Question: Judging by this figure, is the value going up or going down?
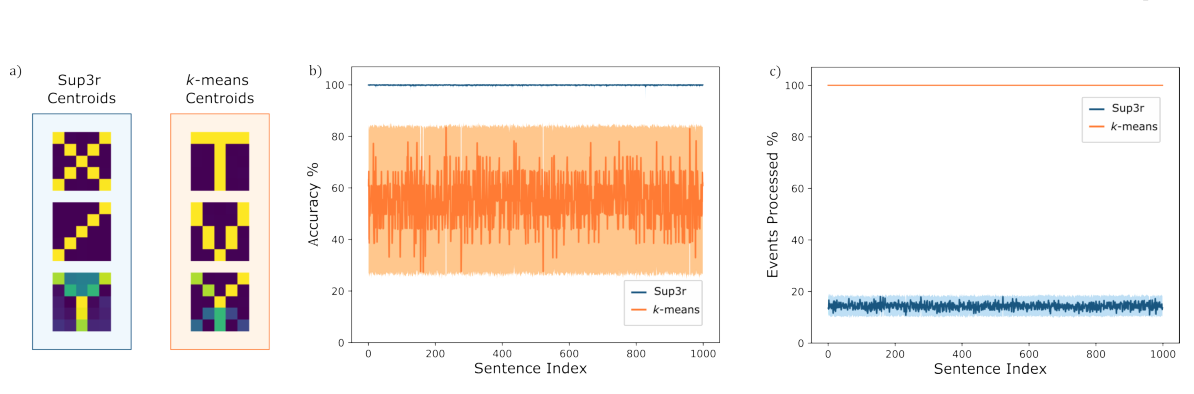
Answer: increasing